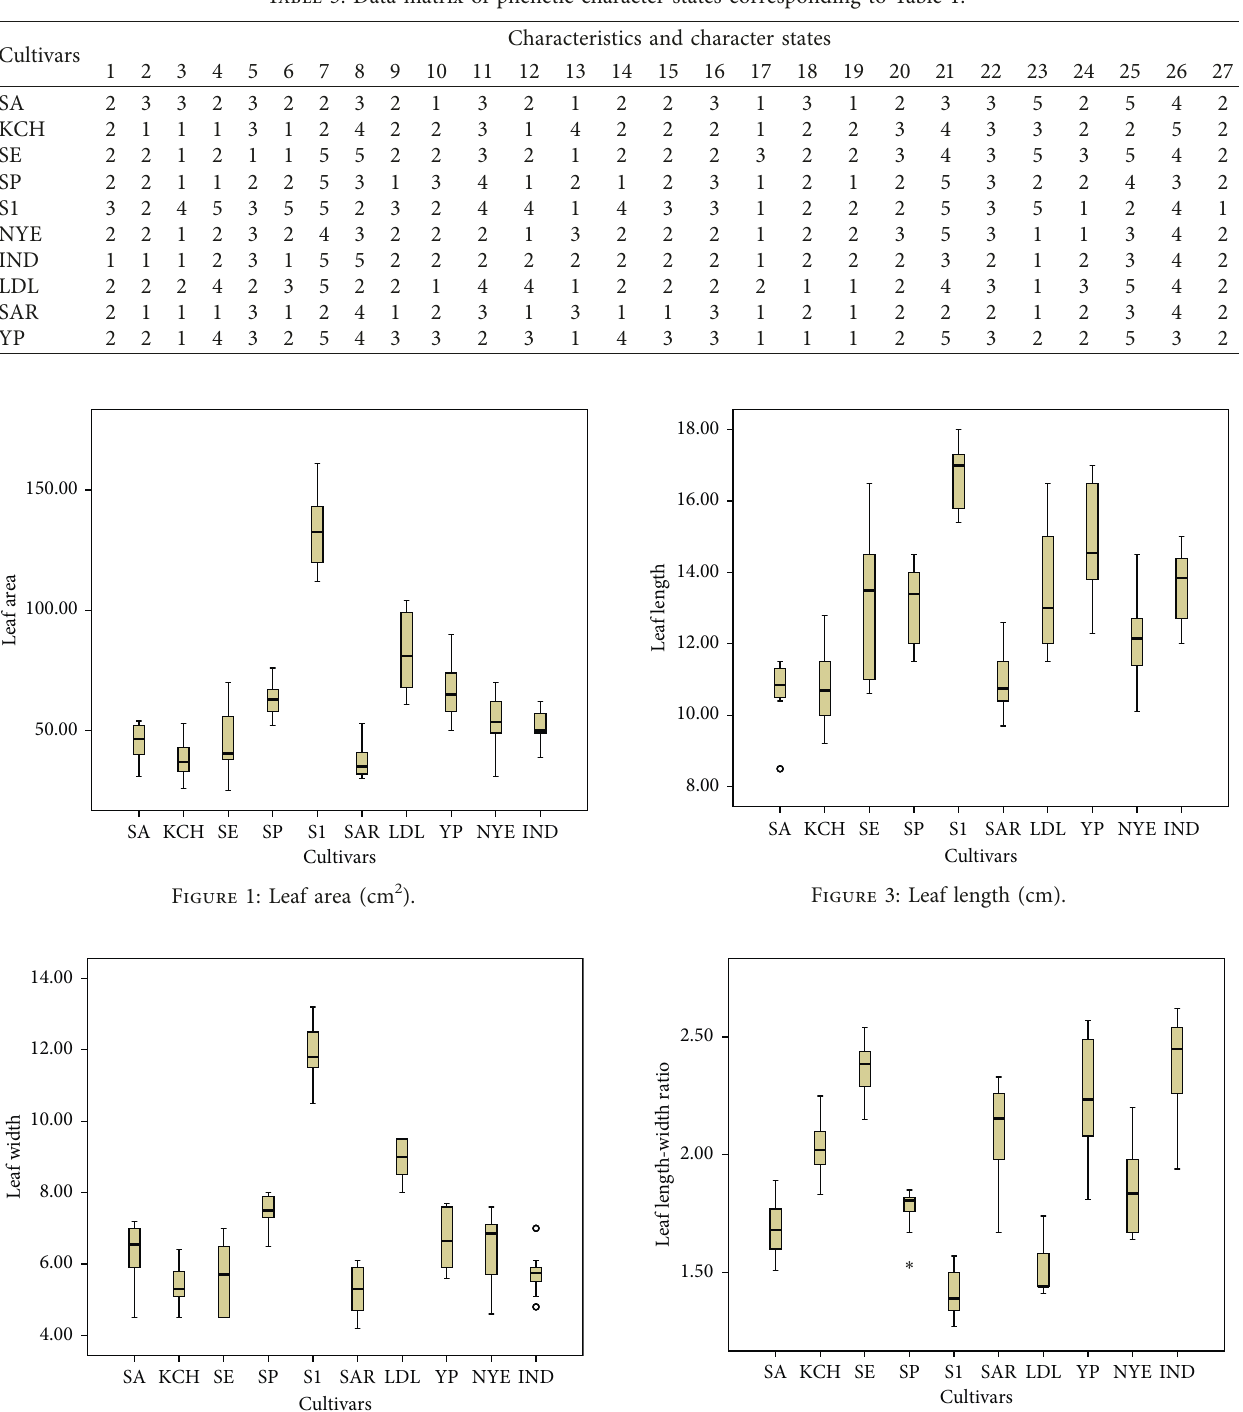
Figure 4: Leaf length-width